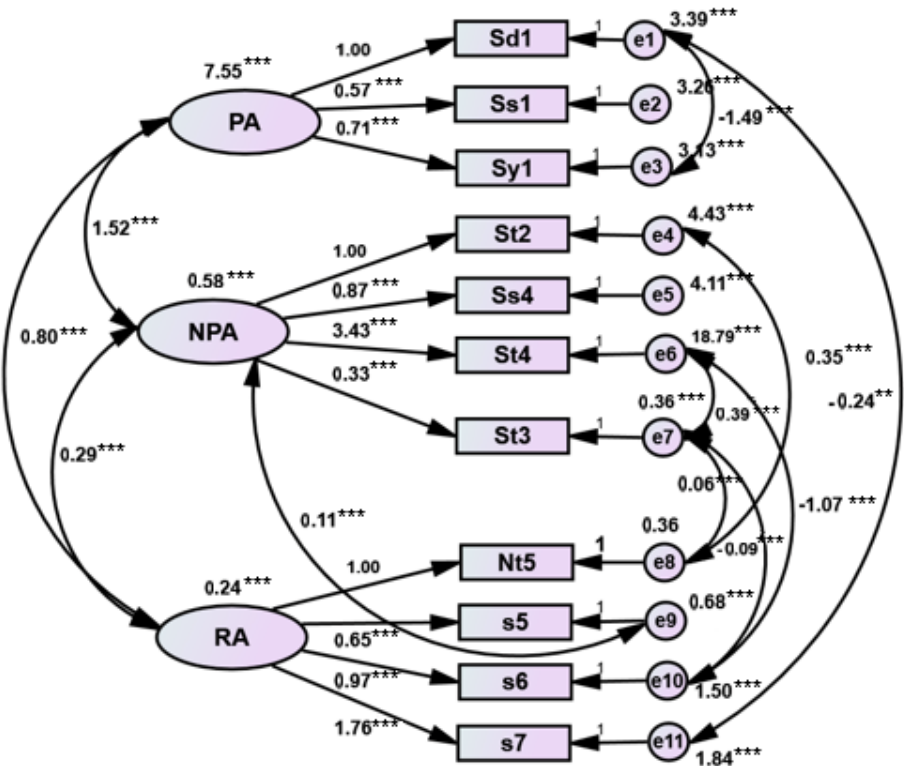
Figure 3. Cognitive skills and reading measurement models (Note: ** p < 0.01. *** p < 0.001, two-tailed).